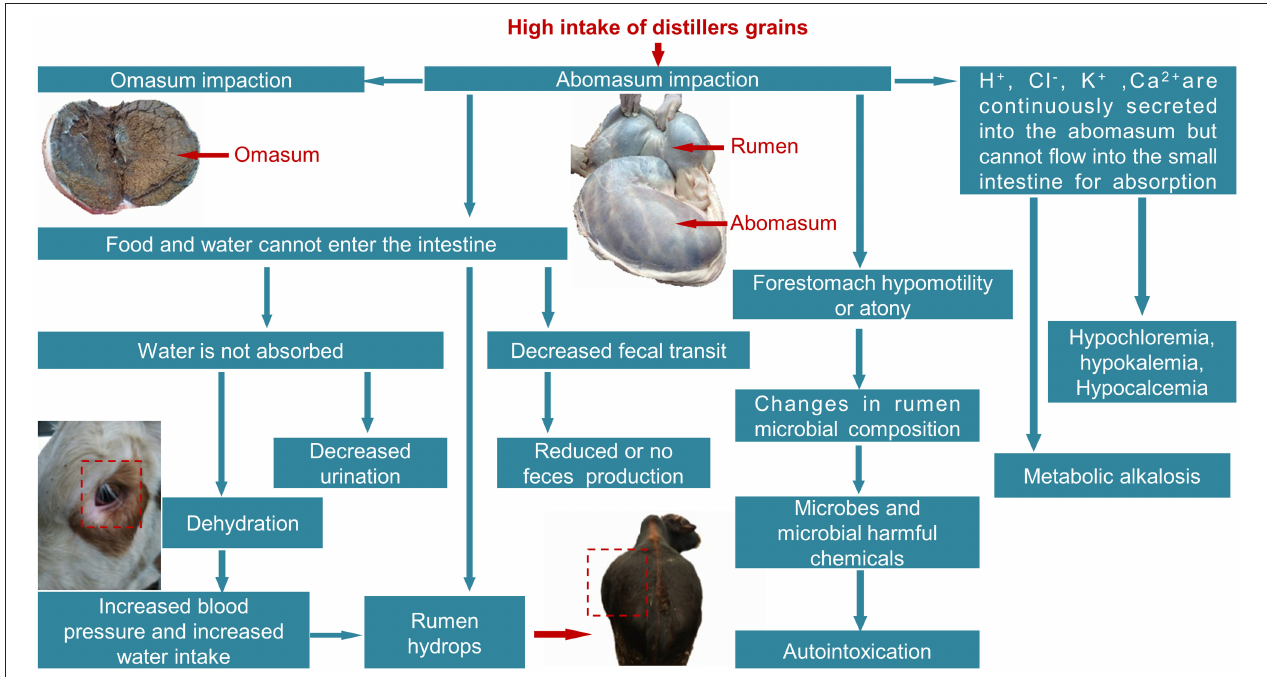
FIGURE 1 | Clinical features and metabolic alterations in AI. Rumen, abomasum, and omasum are indicated with red arrows. The abomasum volume is 2–3 times larger than normal, and omasum contents are hard with necrotic leaflets. Omasum impaction is secondary to ruminal